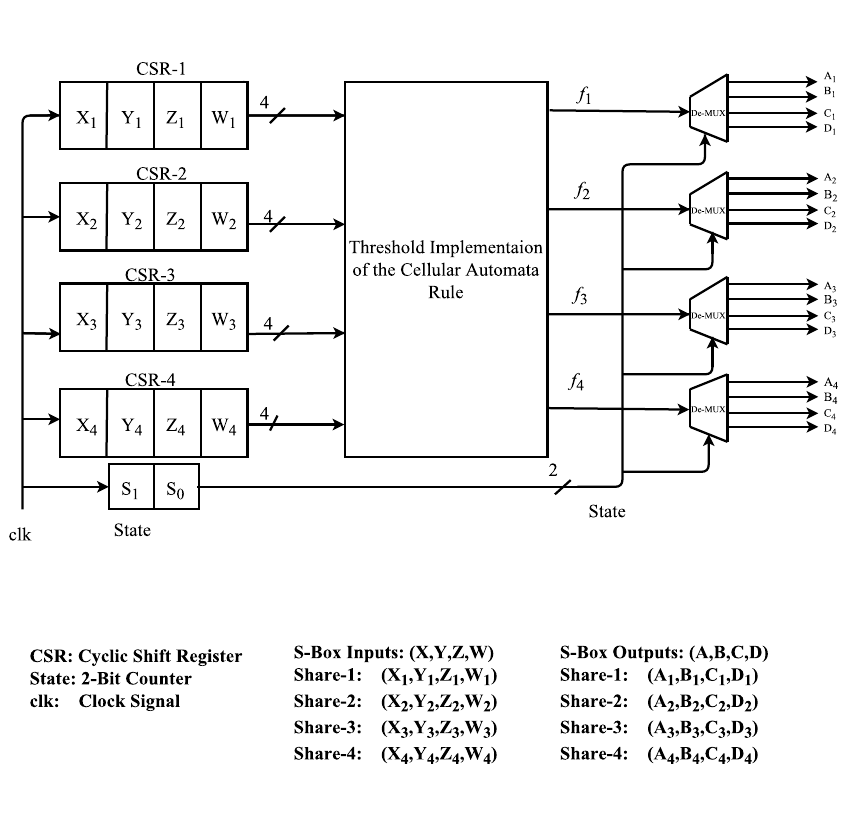
Figure 3.1: Architecture for TI circuits corresponding to CA-based